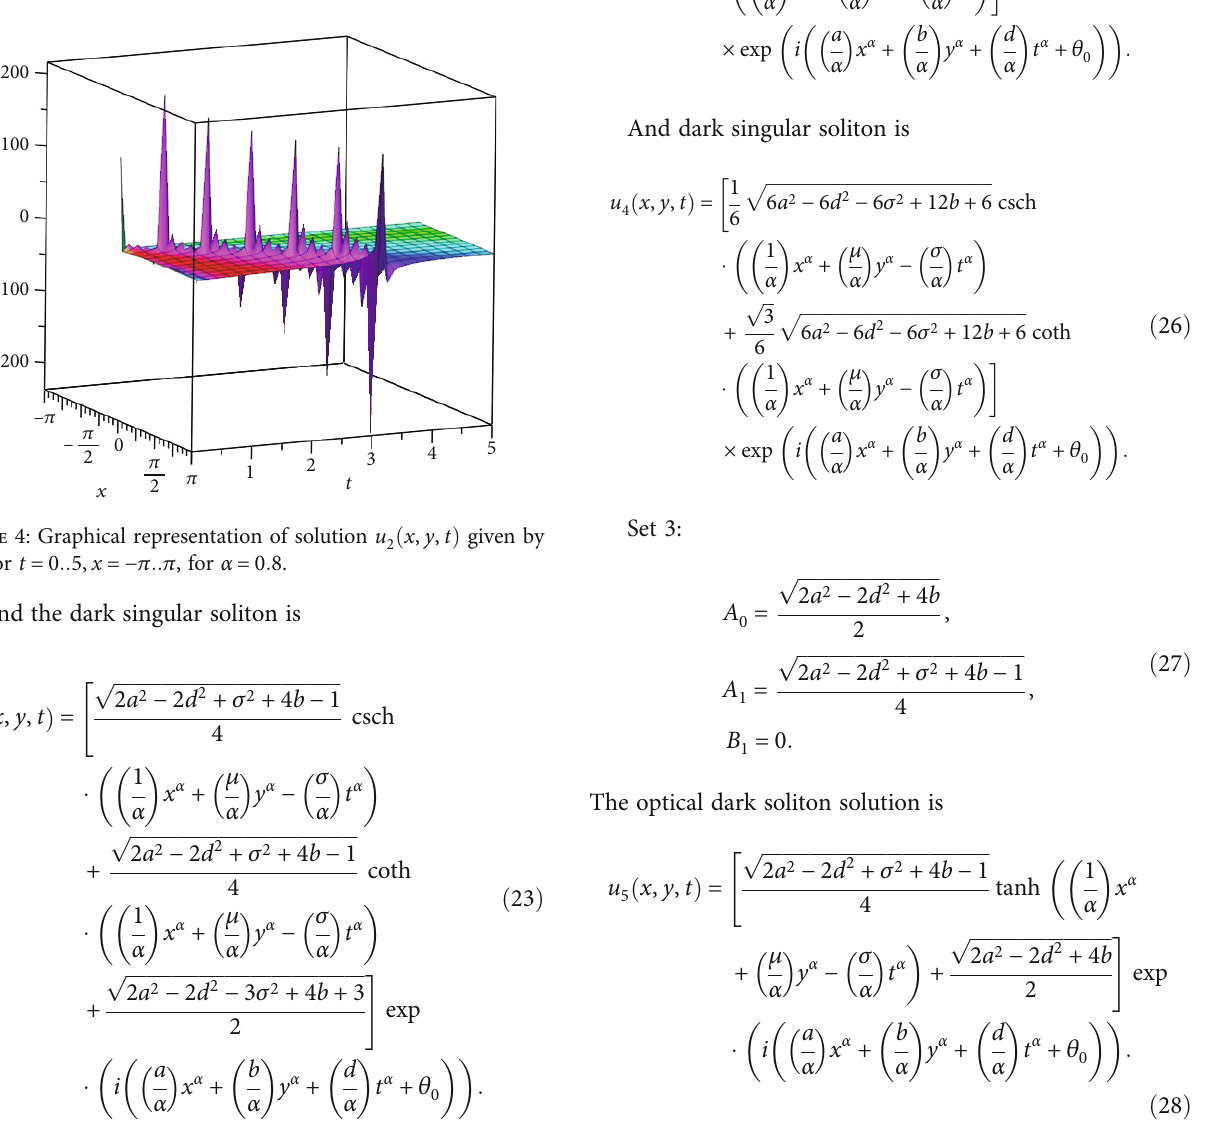
Figure 3: Graphical representation of solution u (22) for t = 0 :: 5, x = − π :: π , for α = 0 : 2 .